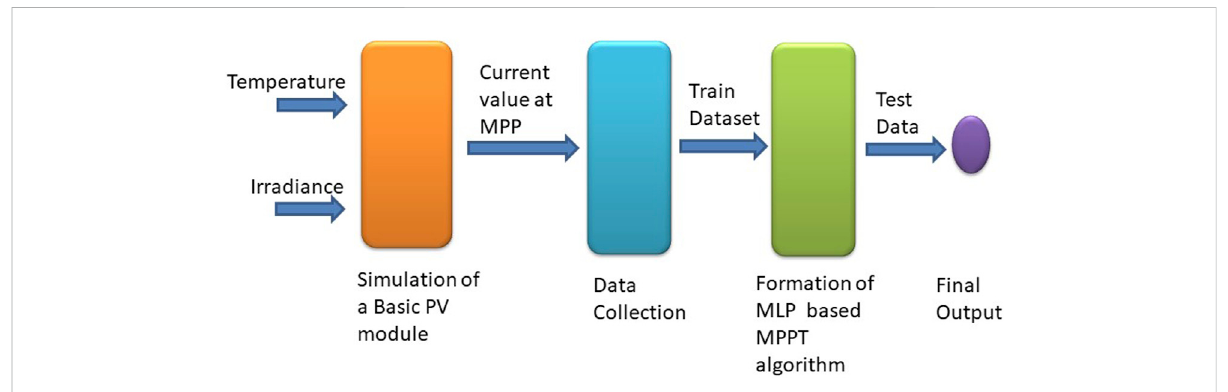
FIGURE 4 Work fl ow diagram of the proposed methodology.